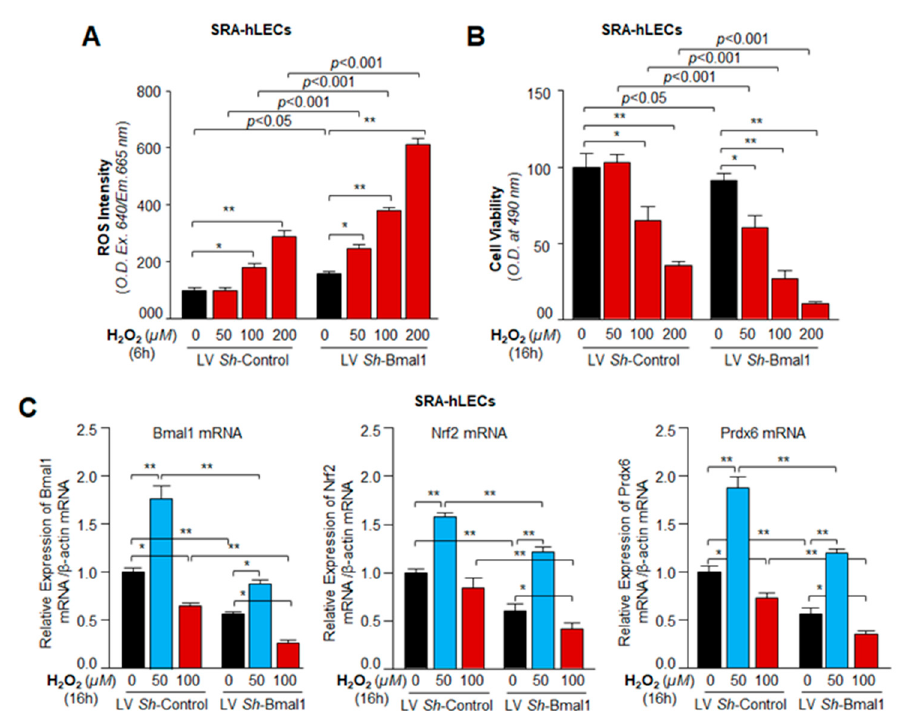
Figure 8. Bmal1 ‐ depleted SRA ‐ hLECs showed enhanced ROS and reduced viability under oxidative stress. SRA ‐ hLECs were infected with lentiviral sh RNA specific to Bmal1. Bmal1 knockdown cells of each group were pooled and plated in 96 ‐ well plate (ROS and MTS assay) or 60 ‐ mm culture plate (RNA isolation). Twenty ‐ four hours later, those cells were exposed to 0, 50, 100, and 200 μ M of H 2 O 2 . ( A ) ROS levels were measured at 6 h of H 2 O 2 exposure. ( B ) Cell viability was examined at 16 h with MTS dye. Data represent means ± S.D. of three independent experiments. Untreated (black bar) vs treated (red bars) with H 2 O 2 , * p <0.05, ** p <0.001. ( C ) Bmal1 ‐ dependent modulation of Nrf2 and Prdx6 expression during oxidative stress. Bmal1 ‐ depleted cells were exposed to 50 μ M (blur bar) and 100 μ M (red bar) H 2 O 2 . Total RNA was isolated from SRA ‐ hLECs lentiviral infected with Sh ‐ Control and Sh ‐ Bmal1 followed by H 2 O 2 exposure for 16 h and RT ‐ qPCR analysis. Bmal1, Nrf2, and Prdx6 mRNA expression were observed with specific primers indicated in Materials and Methods. Data represent means ± S.D. of three independent experiments. LV Sh ‐ Control vs LV Sh ‐ Bmal1 and Untreated (black bar) vs treated (red bar) with H 2 O 2 , * p < 0.05, ** p < 0.001.